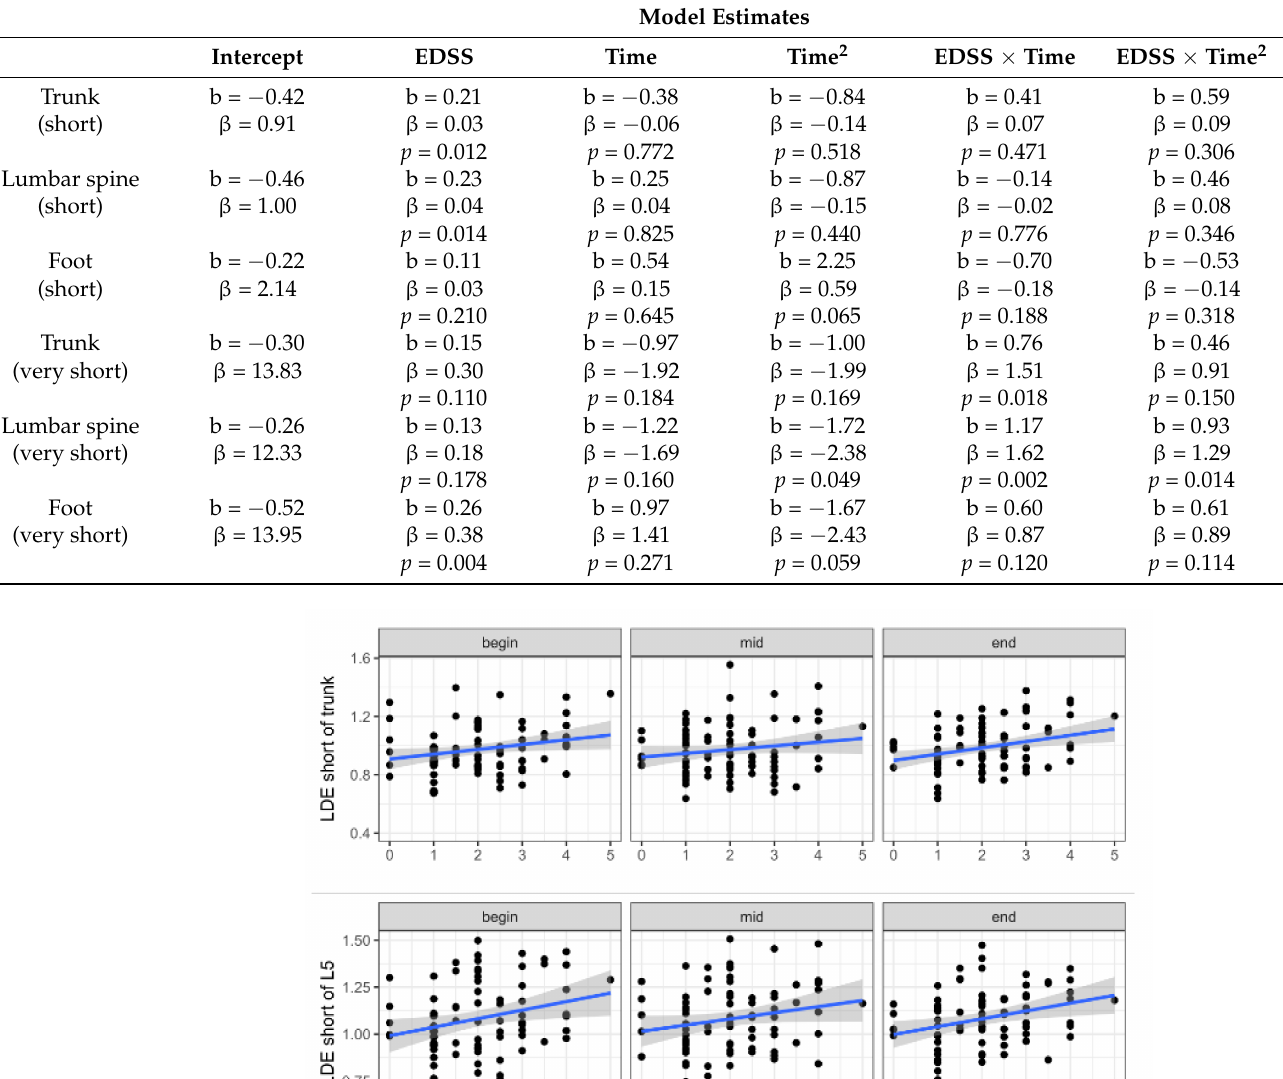
Table 3. LDE measures for PwMS with a varying level of disability. β : model parameter estimate after z-transformation of the LDE values.